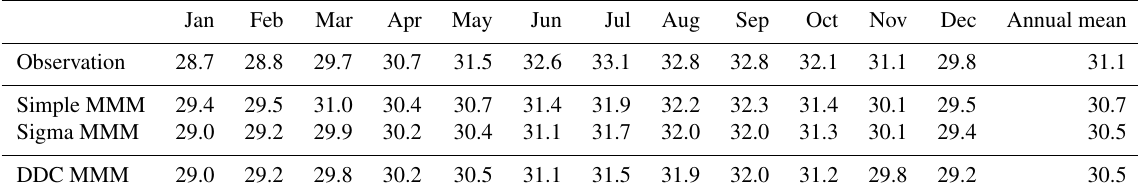
Table 1. Observed and multi-model mean (MMM) global tropospheric ozone column (DU) between 60 ◦ N and 60 ◦ S latitude. Observations are a satellite-based climatology (Ziemke et al., 2011). Model data are from the historical (year 2000) ACCMIP simulation. The simple MMM is the arithmetic mean of all models, the sigma MMM excludes data outside of 1 standard deviation from the simple MMM, and the DDC MMM was generated through cluster-based subsampling.